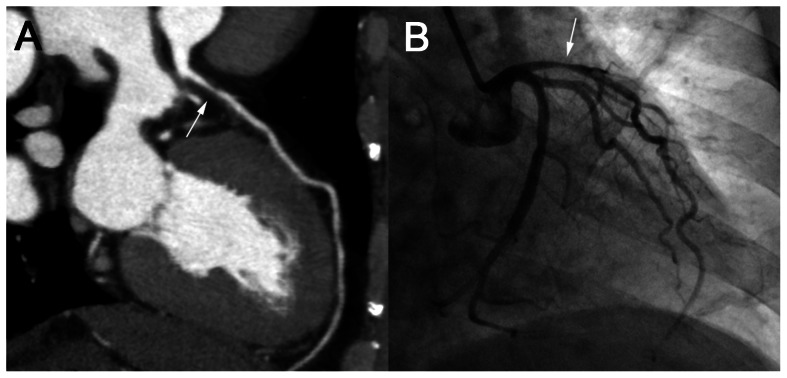
Example of CTA with Doppler-Guided Prospective ECG Gating.A male patient with a BMI of 21.5. The predicted length of DTD was 81 ms, and the exposure timing was preset at 30%–50% during the R-R interval. The scanning heart rate was 78 bpm. CTA with Doppler-guided prospective ECG gating (A) and ICA (B) showed stenosis of LAD (white arrows). The effective dose of CTA was 3.2 mSv.